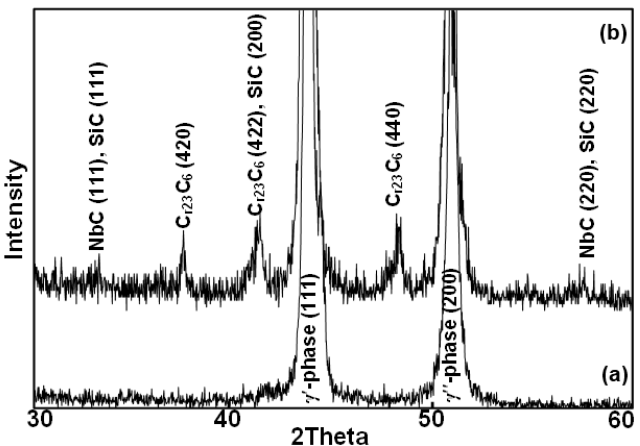
Figure 3. XRD patterns of ( a ) the new tube and ( b ) the used tube.